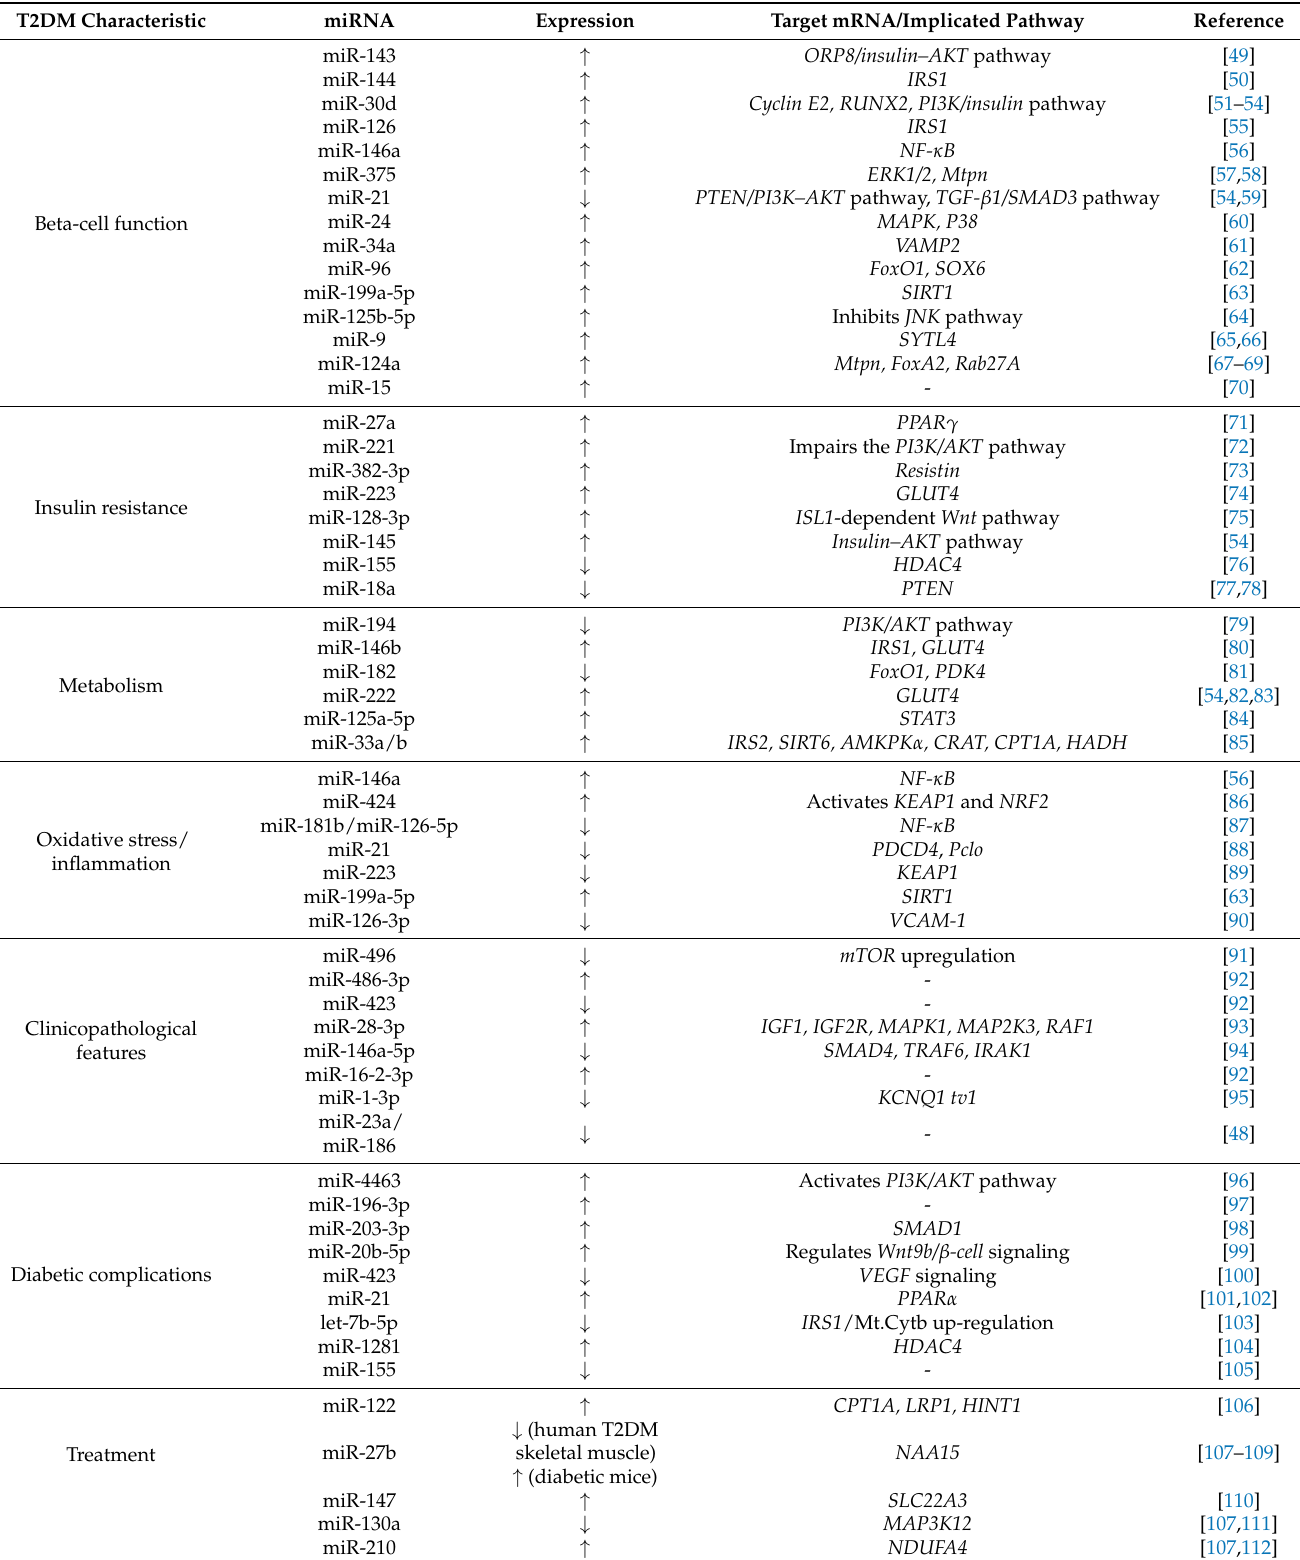
Table 1. miRNA expression and target gene regulation in type 2 diabetes mellitus